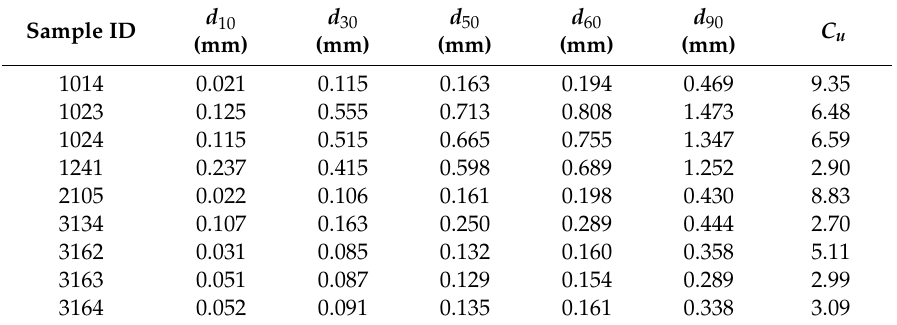
Table 3. Soil gradation parameters of sandy soils tested by the instantaneous profile